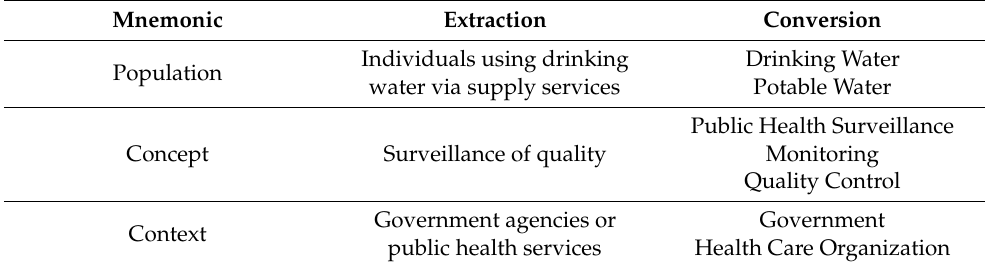
Table 2. Conversion of adopted mnemonic